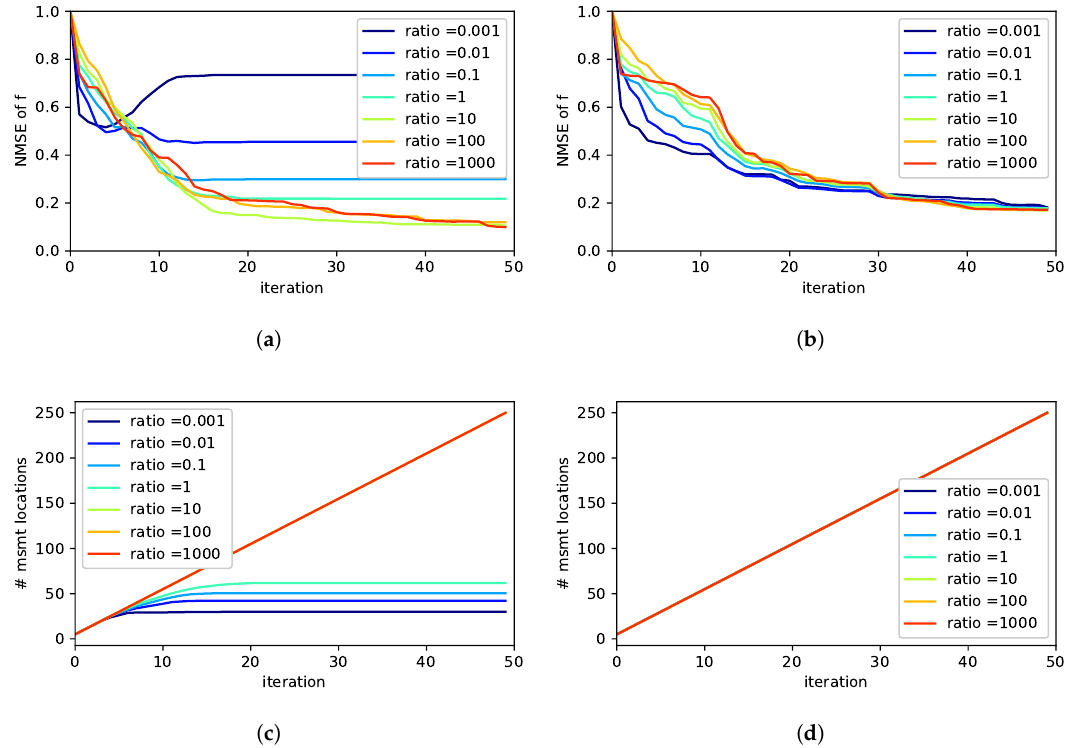
Figure 3. Effect of different ratios of τ m / τ s : On the left in ( a , c ) the case with a sparsity inducing prior is shown, on the right in ( b , d ) the case without. The first row ( a , b ) depicts the exploration performance by means of the NMSE of the estimated concentration field. The second row ( c , d ) plots the number of measurement locations. Note that in each iteration 5 measurements are carried out, however eventually at the same locations as before.